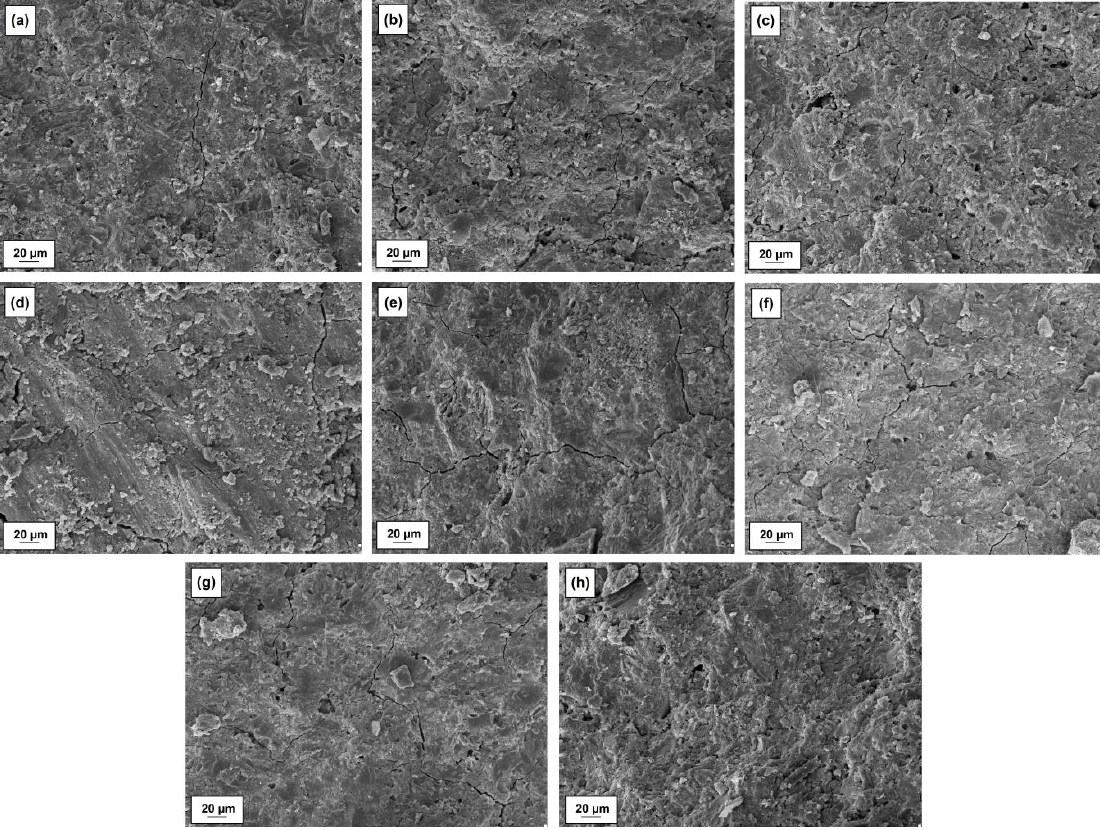
Figure 9. SEM images of pure cement mixture ( a ) and cement mixture with the addition of silica ( b ), lignin ( c ) and silica-lignin hybrid materials with different weight ratios of the components used–5:1 wt./wt. ( d ), 2:1 wt./wt. ( e ), 1:1 wt./wt. ( f ), 1:2 wt./wt. ( g ) and 1:5 wt./wt. ( h ).